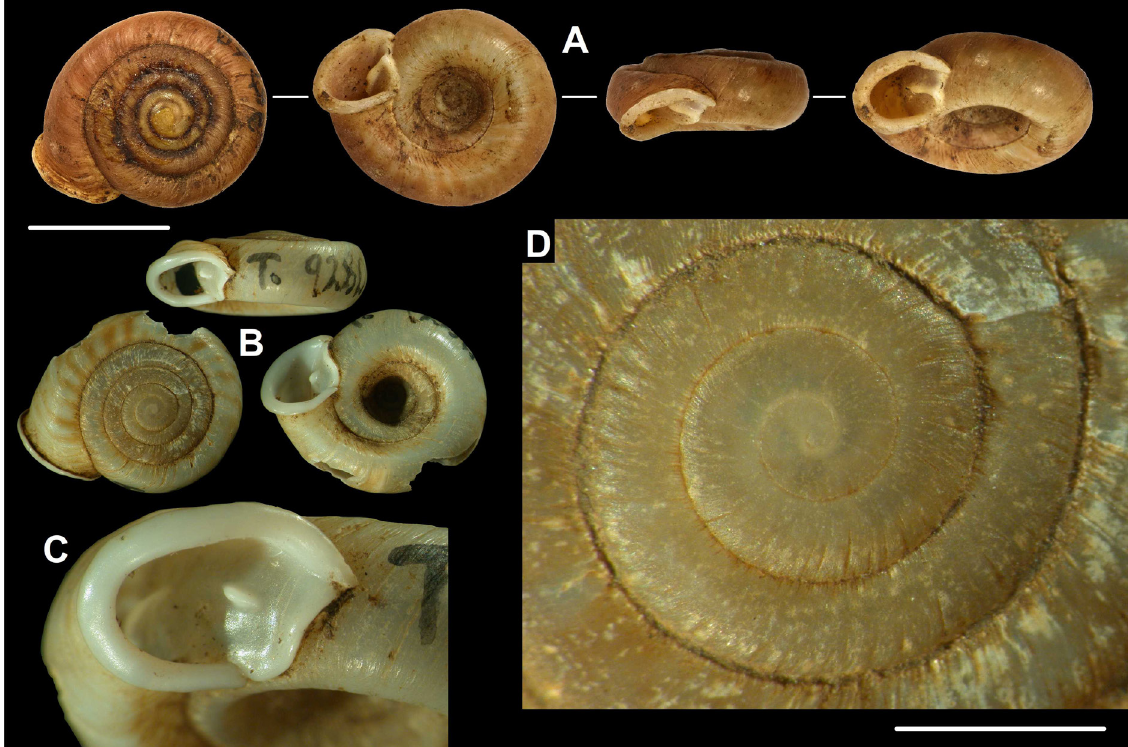
Fig. 43. Photos of Plectopylis linterae Möllendorff, 1897. A . Shell from Myanmar (RAME 1720/1909/ D7.48a). B–D . Holotype (SMF 9280). Scale bars: D (protoconch) = 2 mm; A–B (shells) = 10 mm; C not to scale. Photos: G. Oliver (A) and B. Páll-Gergely